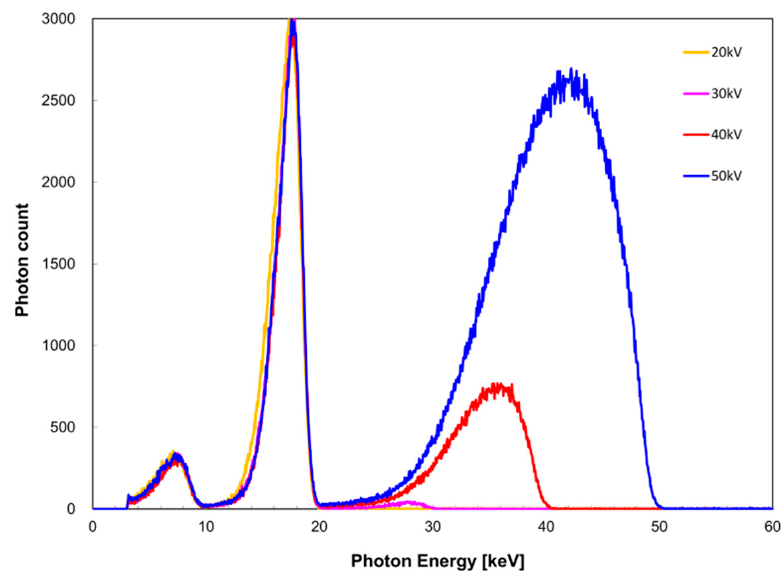
Figure 2. Tube voltage dependence of X-ray spectrum when the zirconium filter was used.